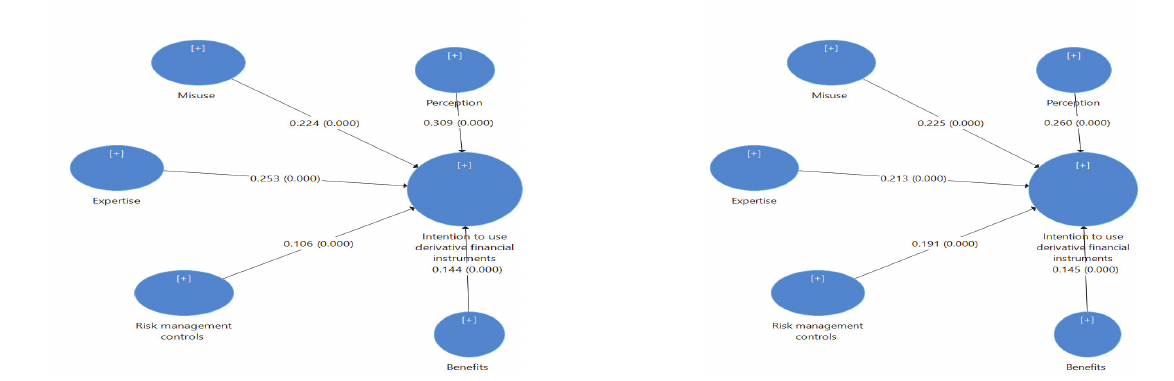
Fig. 7. Results of multi-group analysis with group of employee positions